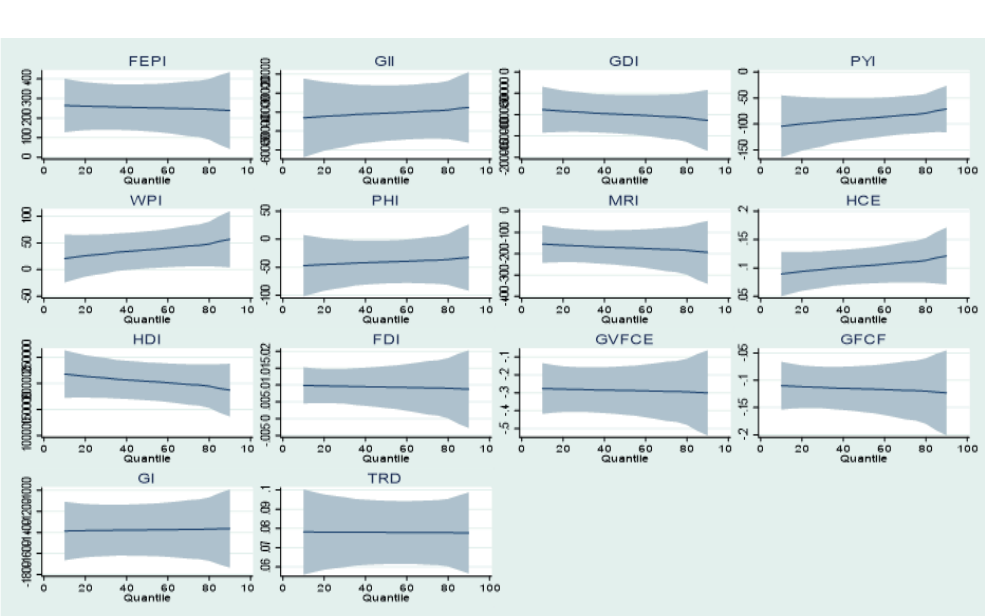
Fig. 1. Quantile estimation: The shaded regions are the (95 %) intervals of certainty for the quantile regression estimates.